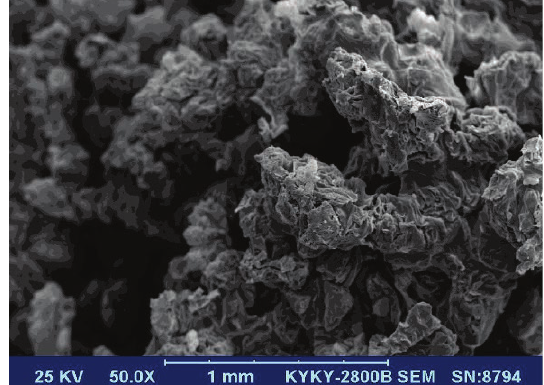
ambience and a calefactive ratio of 20.0 K min -1 ). 2